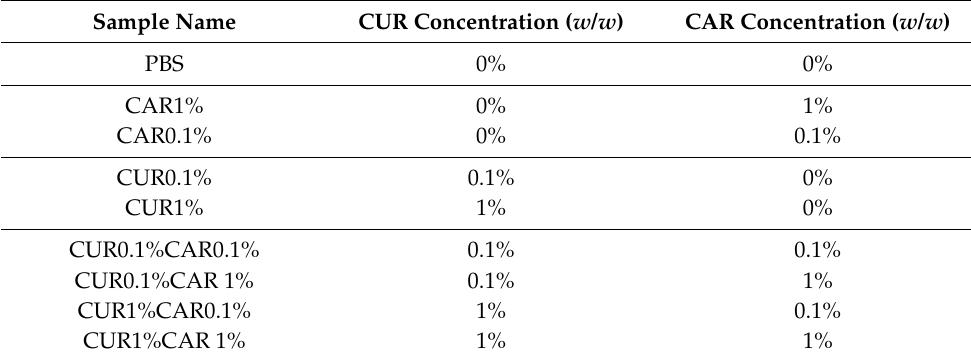
Table 1. CUR and CAR concentrations ( w / w ) per weight of PBS